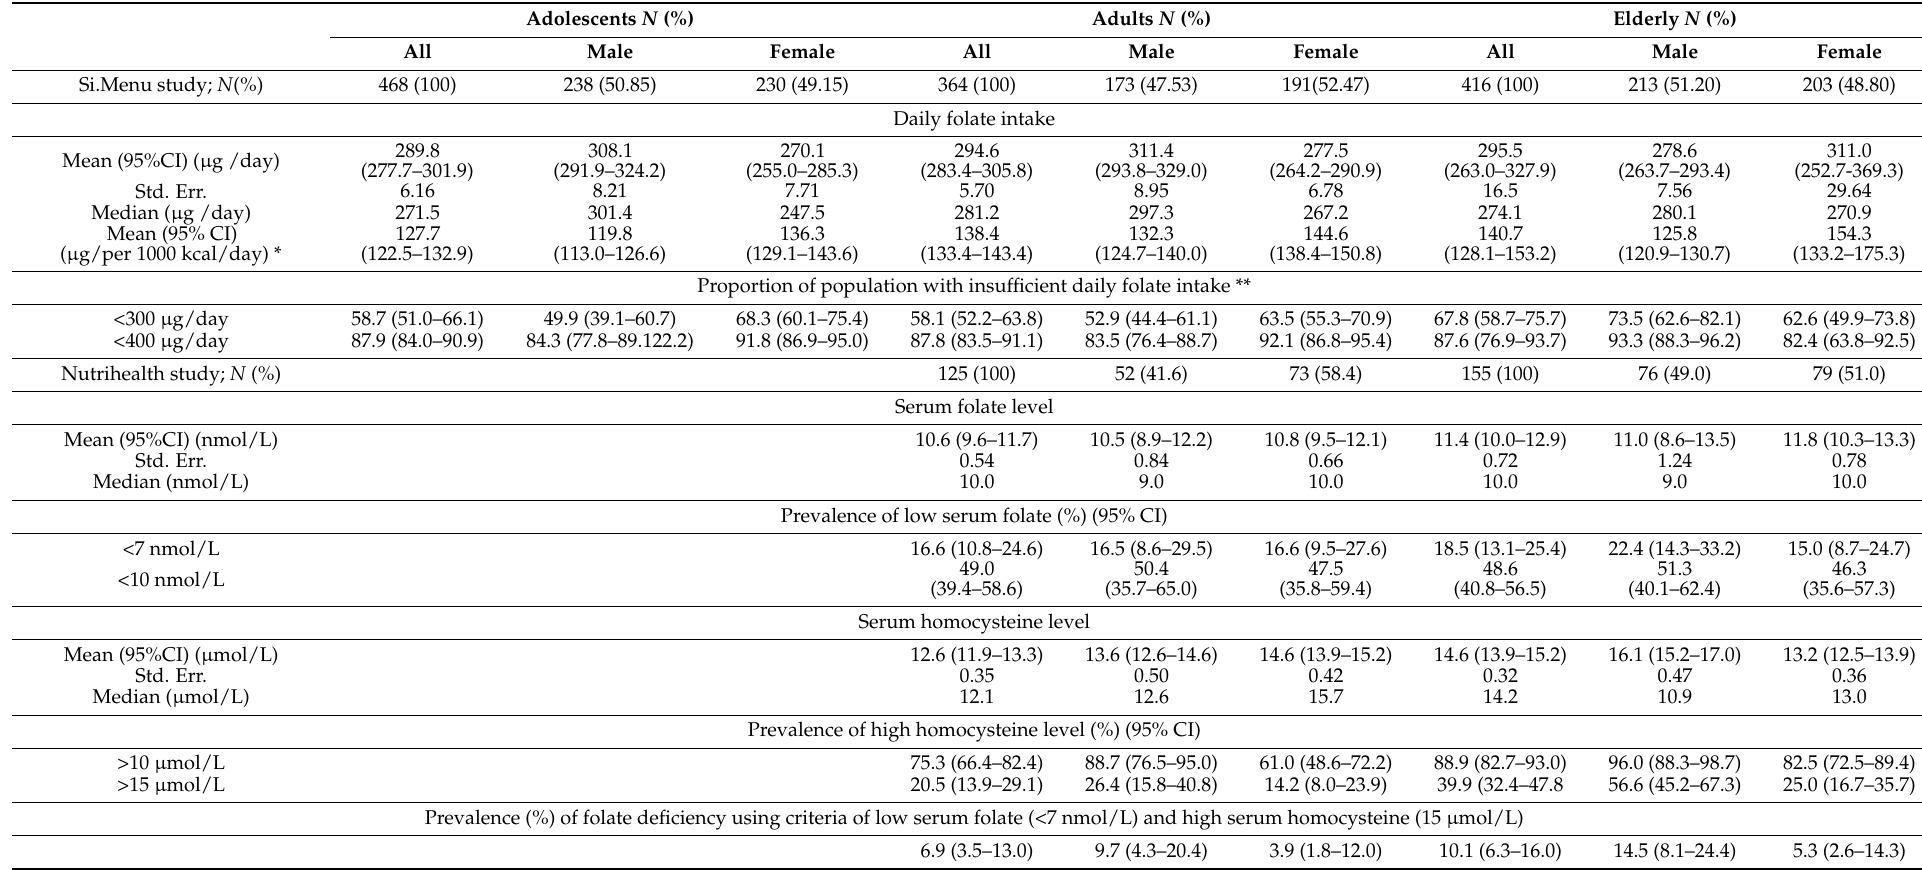
Table 2. Estimated population-weighted usual daily folate intake and indicators of folate deficiency (95%